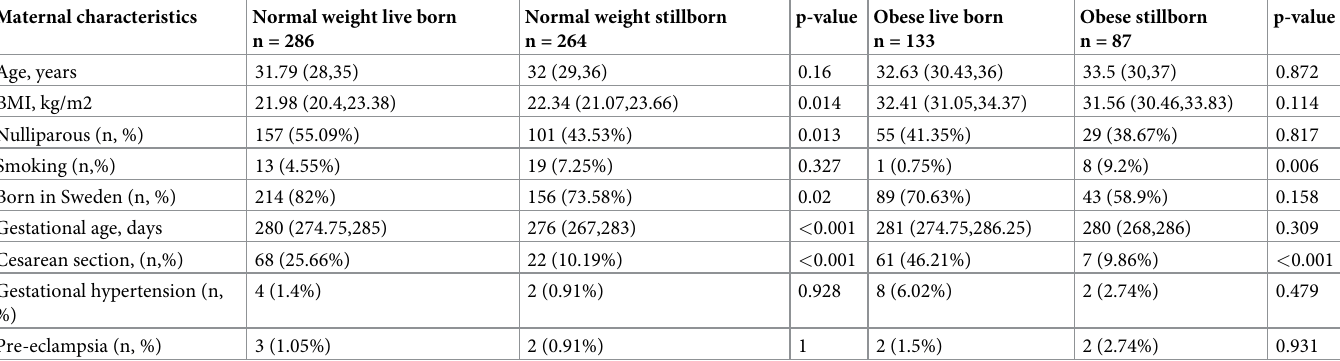
Table 1. Maternal characteristics, term live born and stillborn infants to normal weight and obese women. Maternal